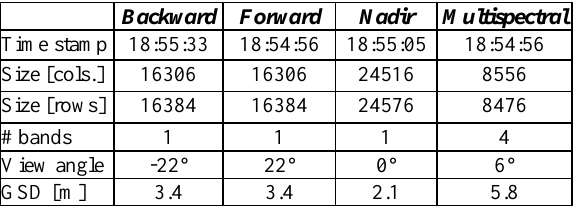
Table 1. Characteristics of ZY-3